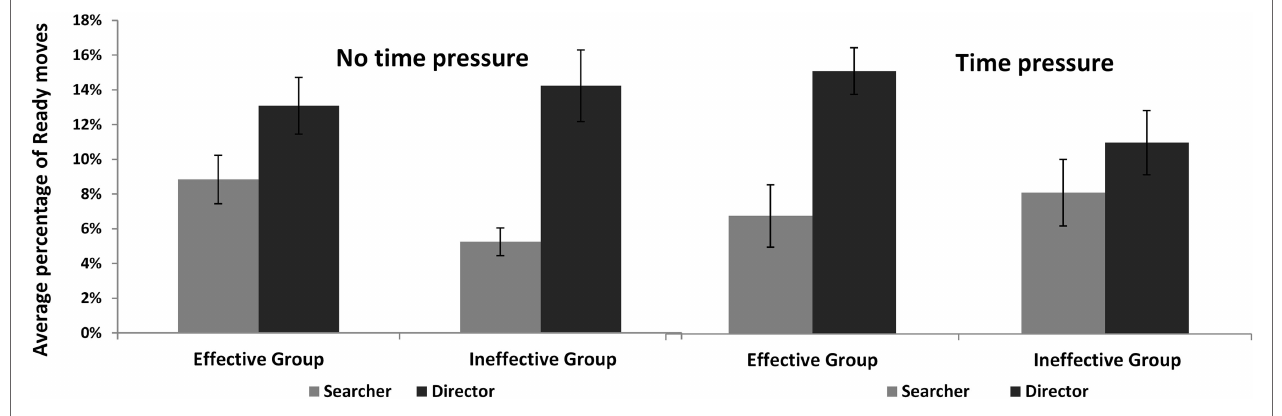
FigUre 6 | group × speaker × Time Pressure interaction for Ready moves . Error bars represent